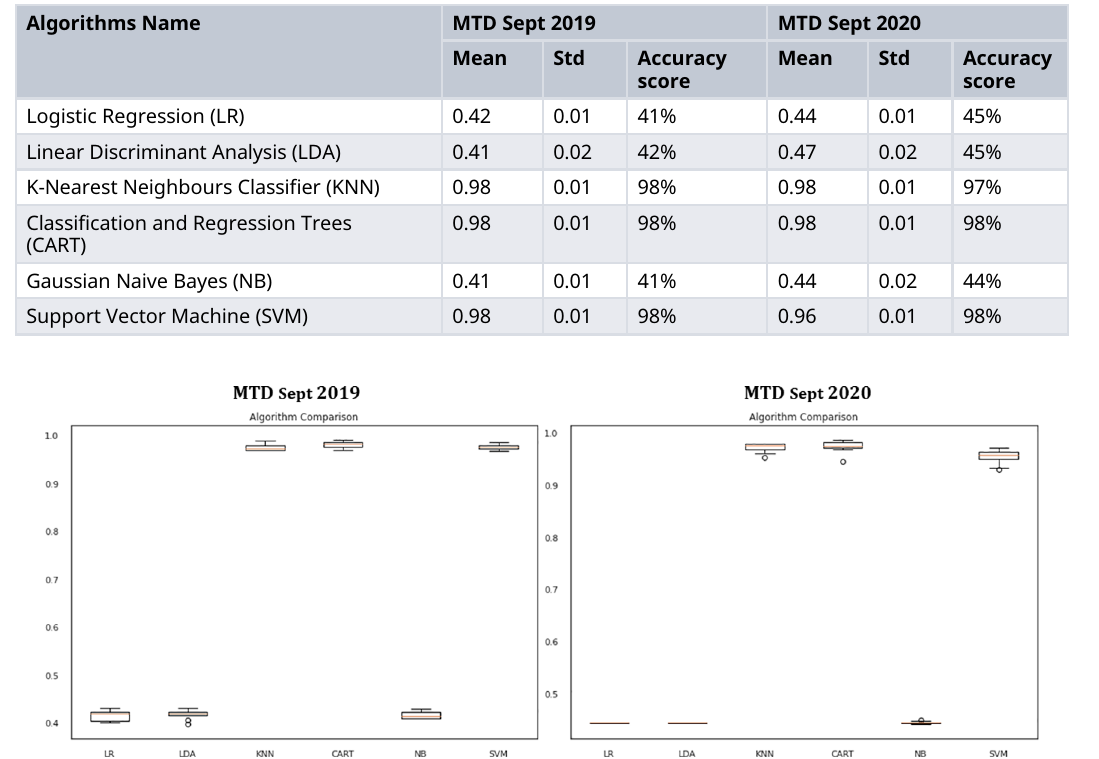
Table 13. Machine learning algorithms comparison results.